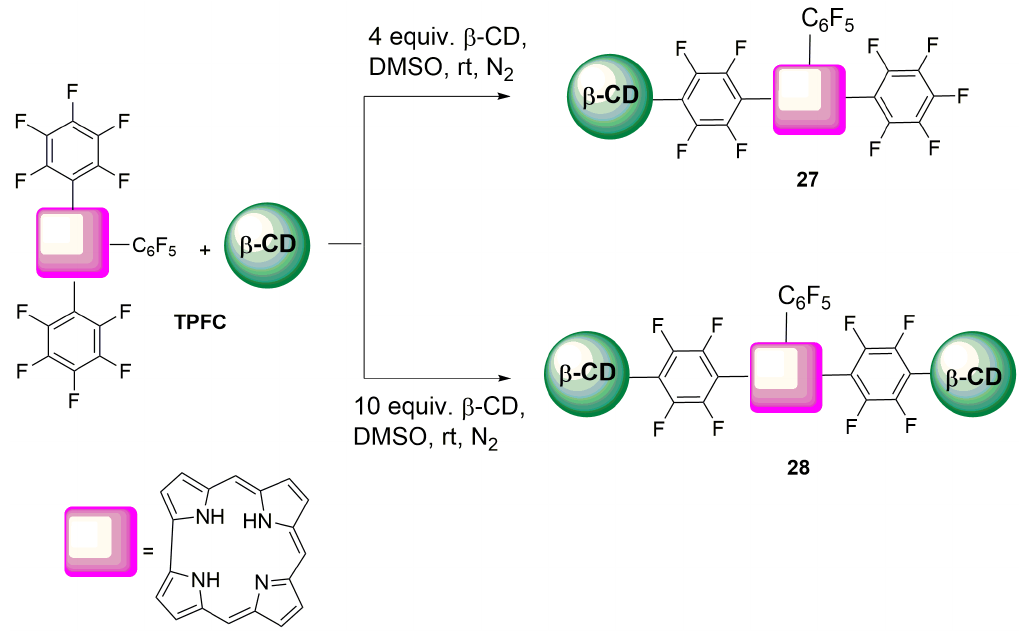
Figure 25 - Synthesis of corrole β-cyclodextrin conjugates Corr-β-CD 27 and Corr-β-CD 28